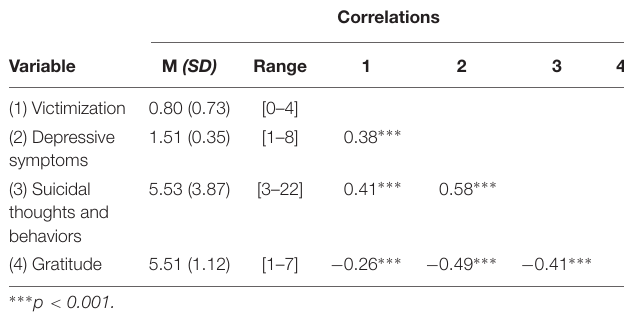
TABLE 2 | Descriptive statistics and bivariate correlations between the studied variables among total sample.